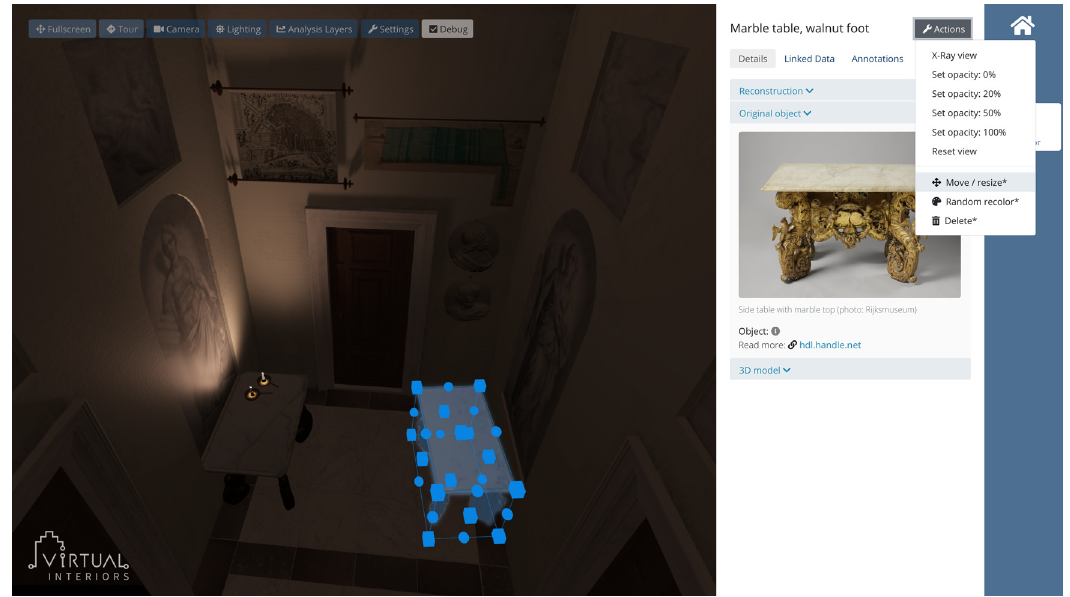
Figure 11: Rearrangement of objects within the research